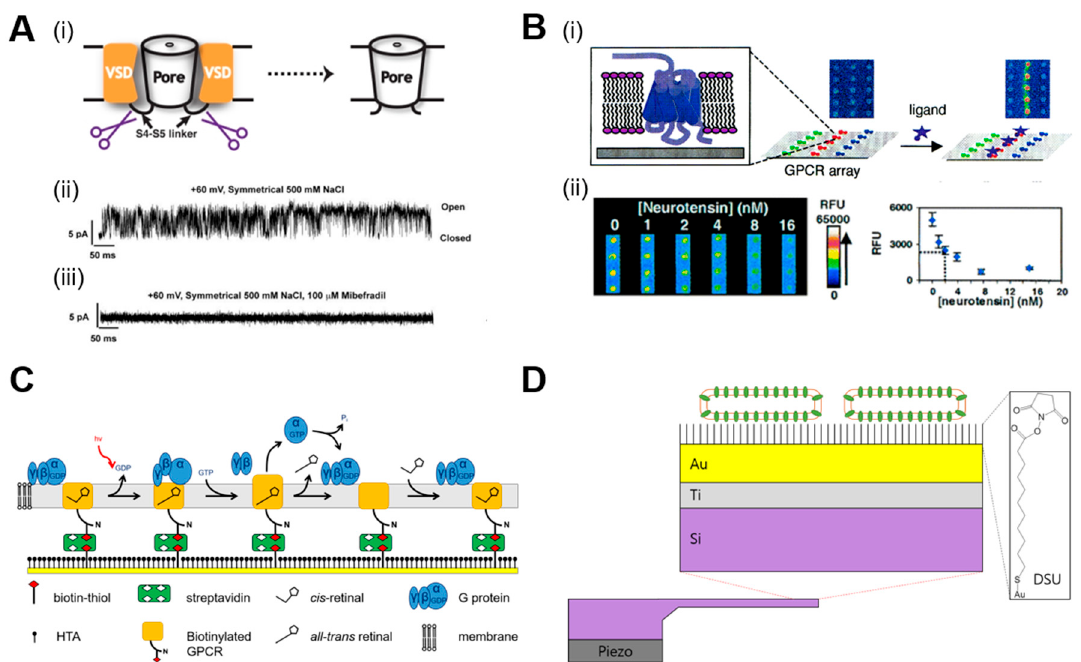
Figure 6. ( A ) (i) Cartoon depicting the strategy for creating a pore-only channel. Voltage-sensing domains (VSDs) are cut from pore domains. Bilayer recordings of the pore domain (Na V Sp1p) at +60 mV in symmetrical 500 mM NaCl before (ii) and after (iii) the addition of 100 µM mibefradil [105]. (Reproduced with permission from Shaya et al., Proc. Natl. Acad. Sci., 2011. Copyright© 2011 NAS) ( B ) (i) Schematic of GPCR microarray. (ii) Fluorescence images and inhibition curve of arrays of the